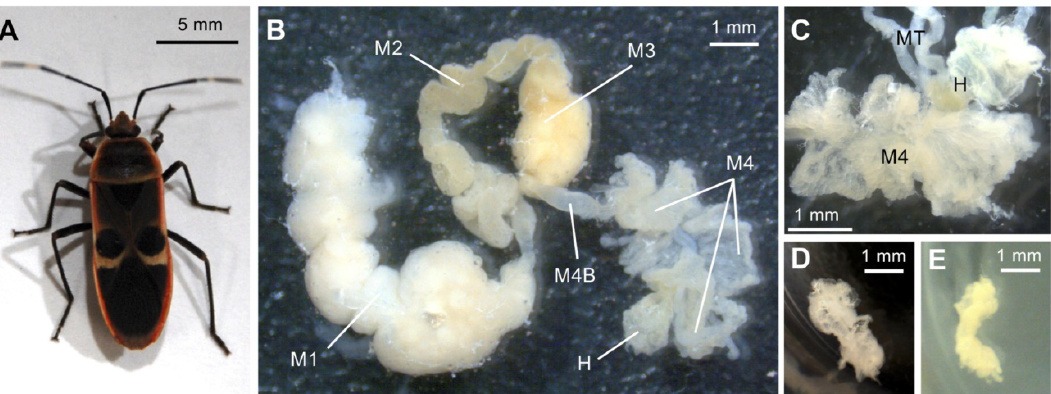
Figure 1. The symbiont-harboring midgut crypts of Physopelta gutta . ( A ) An adult female P. gutta . ( B ) The dissected midgut of an adult female P. gutta . The Burkholderia symbiont is specifically localized in the 4th section of the crypt-bearing midgut [31]. ( C ) An enlarged image of the M4 section. ( D , E ) Pre-culture of the midgut crypts in yeast-glucose medium. The midgut crypts before pre-culture ( D )